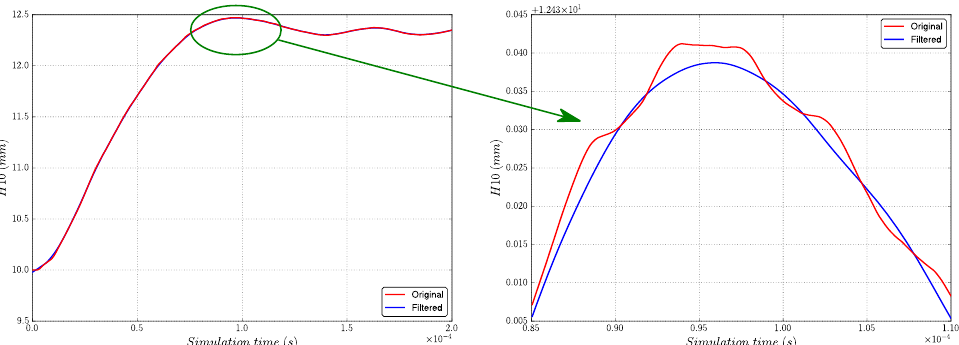
Figure 6. The high frequency filtering for H 10 of dynamic tensile test.